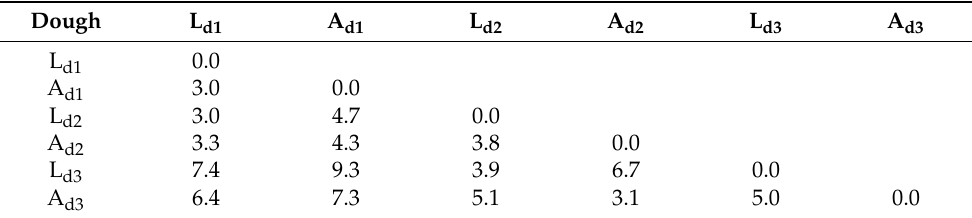
Table 7. Soft independent modeling of class analogy (SIMCA) interclasses distances from a 6-class SIMCA A. diaperinus vs. L. migratoria doughs model.